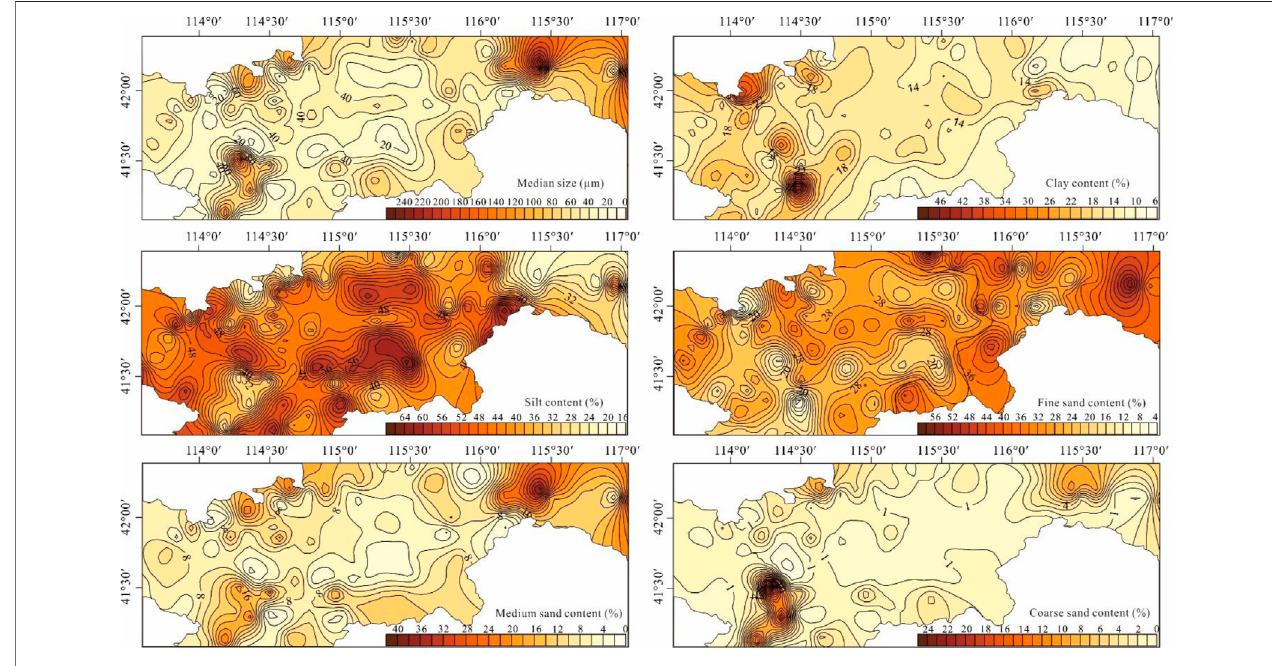
FIGURE 4 | Spatial distribution of grain size parameters.